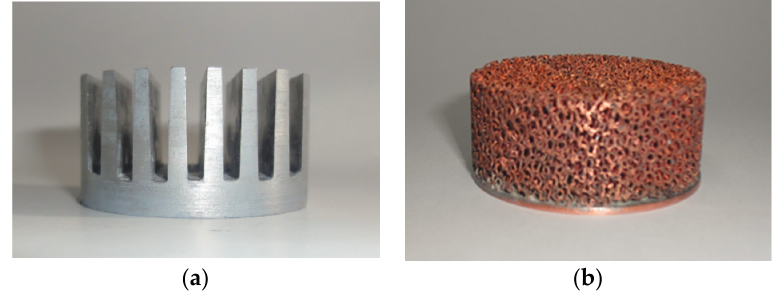
Figure 4. Two photos of heat sinks; ( a ) ALFHS and ( b ) CUFHS.